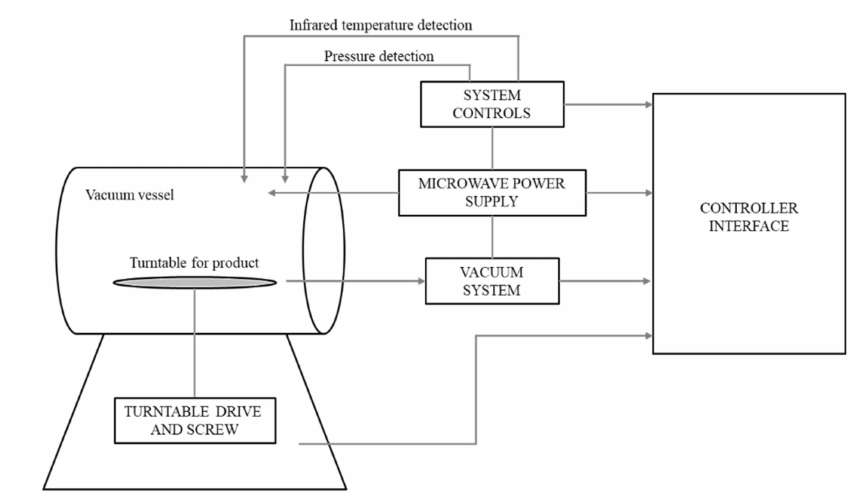
Figure 1. Schematic diagram of the Radiant Energy Vacuum (REV)-drying